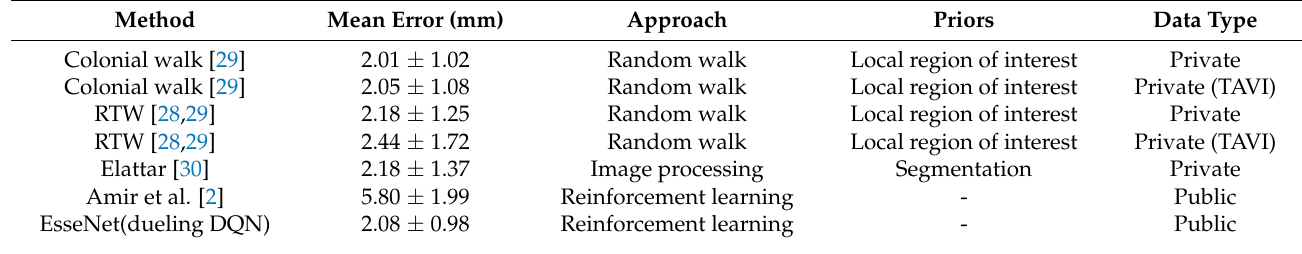
Table 3. General comparison with the existing works for the localization of coronary ostia. It is difficult to compare the methods listed in the table directly since their results were reported on the different datasets used in the source papers. RTW [28] was introduced for 3D human pose estimation, but it is newly applied for localization of coronary ostia in the other work [29]. Hence, the result of RTW can be referred from the paper [29]. TAVI cases are the CT images scanned from patients who have cardiovascular diseases. Note that all the other methods use some prior information, while the proposed method and Amir’s method do not use any prior information.; RTW, random tree walk; TAVI, transcatheter aortic valve